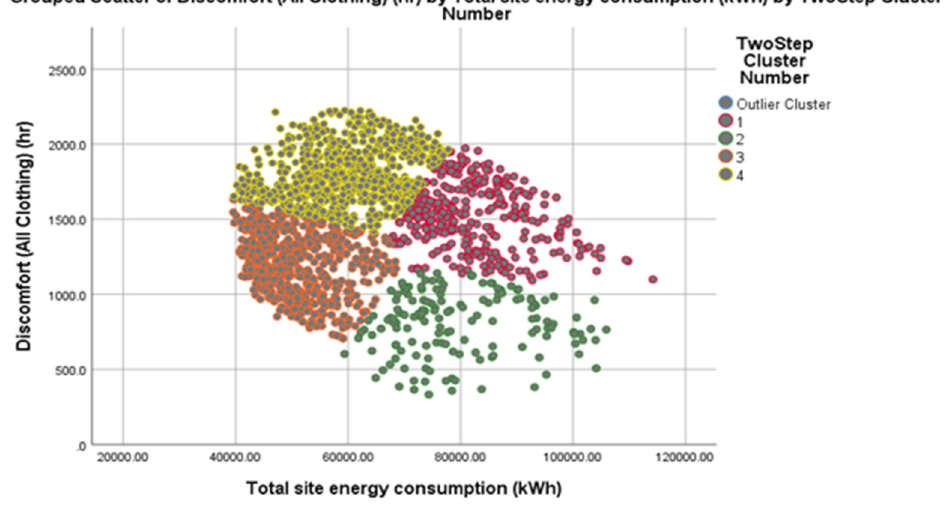
Figure 19. Clustering groups analysis